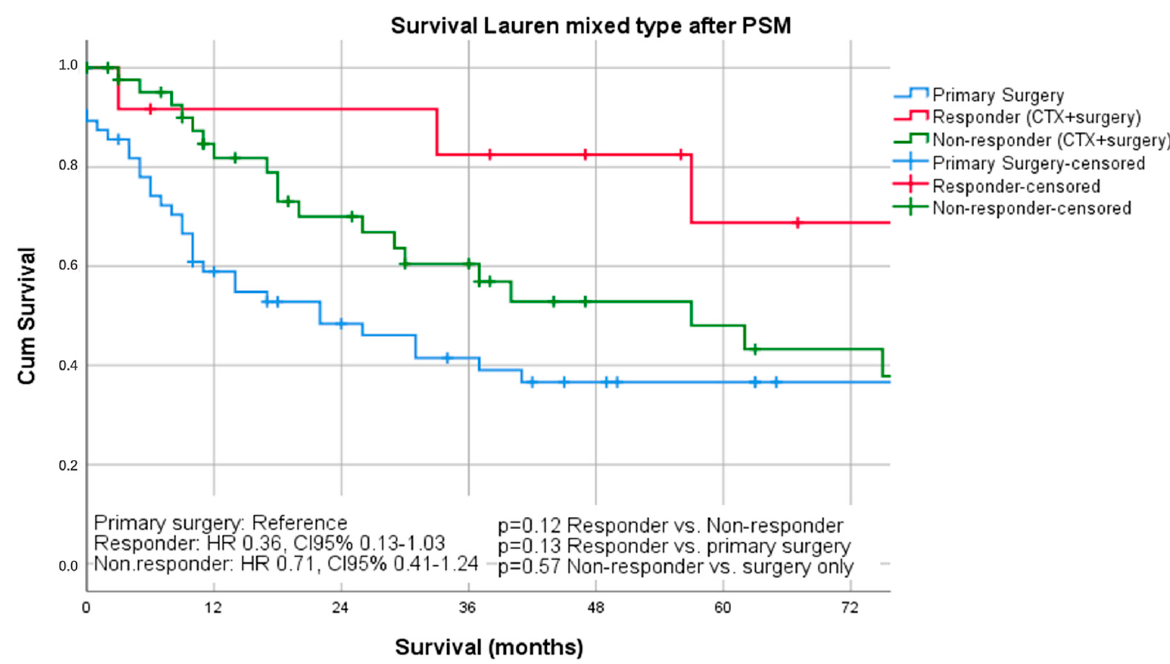
Figure 6. Survival curves for mixed subtype after PSM differentiated by responders, non-responders and surgery only.